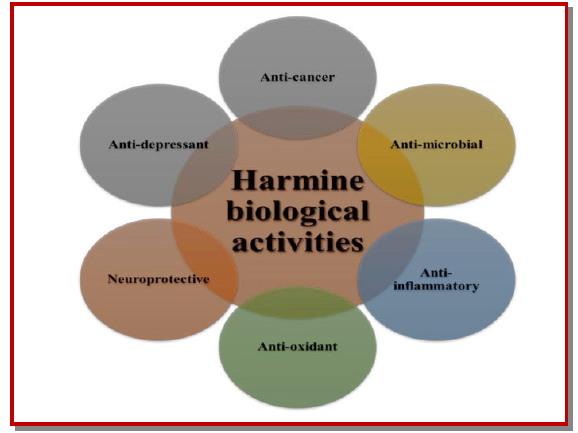
Figure 2: Biological activities of harmine